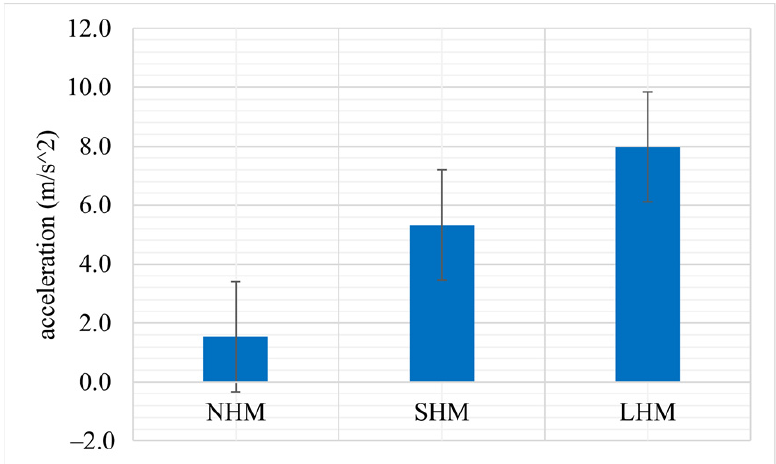
Figure 4. Mean head acceleration over participants for all three movement conditions (NHM, SHM, LHM). Error bars indicate standard error across participants.